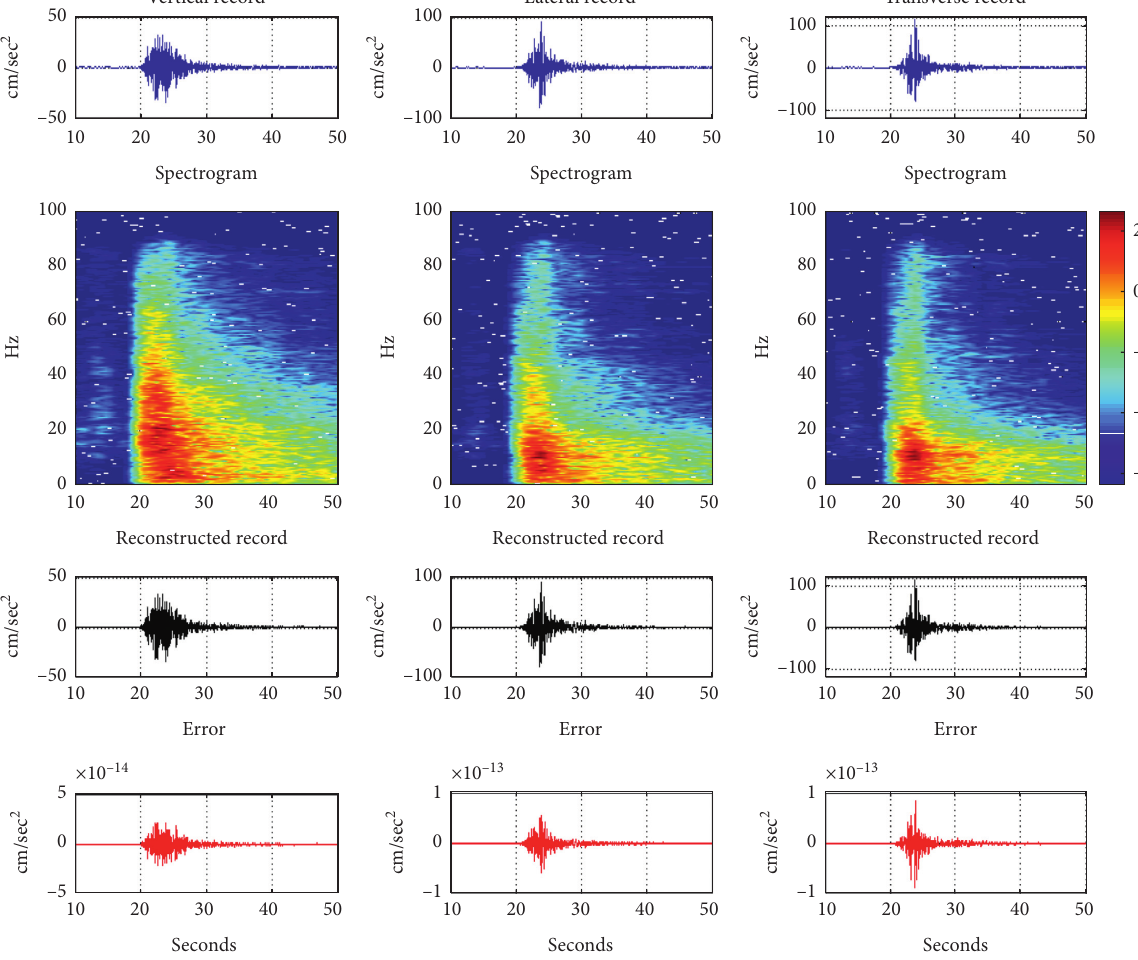
Figure 2: Short-time Fourier analysis of the Mosha 2020 earthquake accelerograms recorded in Mosha3